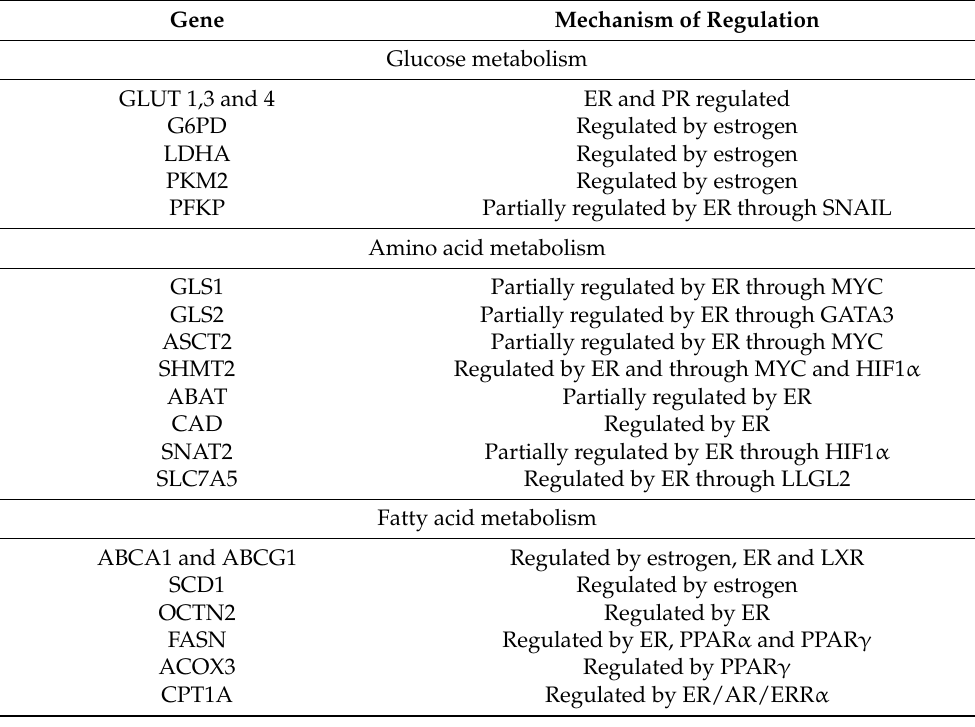
Table 1. Summary of key metabolic genes regulated by nuclear hormone receptor activity in HR+ breast cancer.